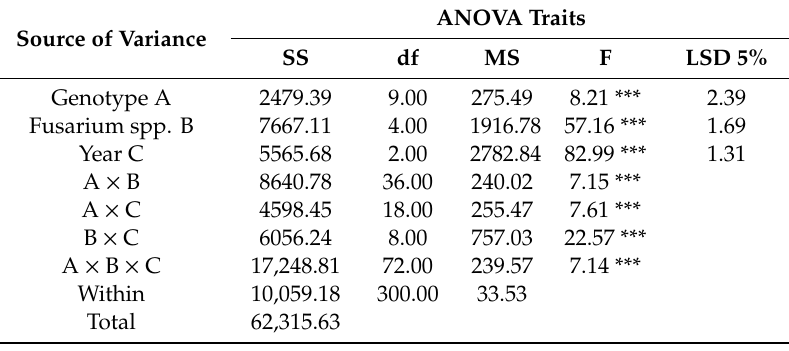
Table 18. SR resistance test in maize, ANOVA from the data of Table 16.